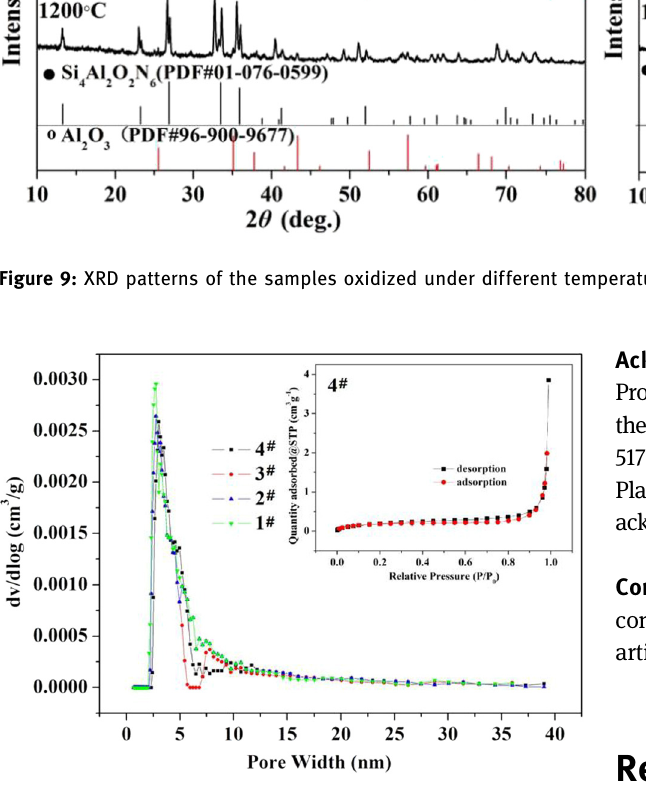
Figure 10: Pore size distribution and nitrogen absorption – desorp - tion isotherm of